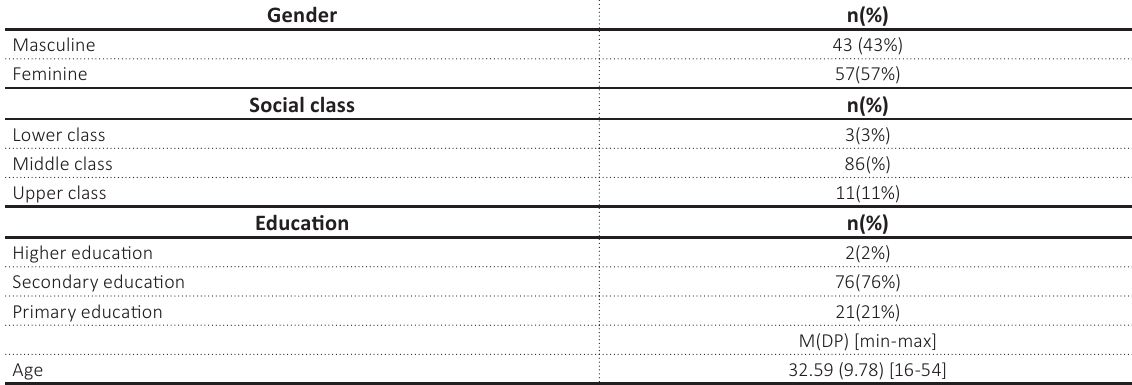
Table A1. Characteristics of a